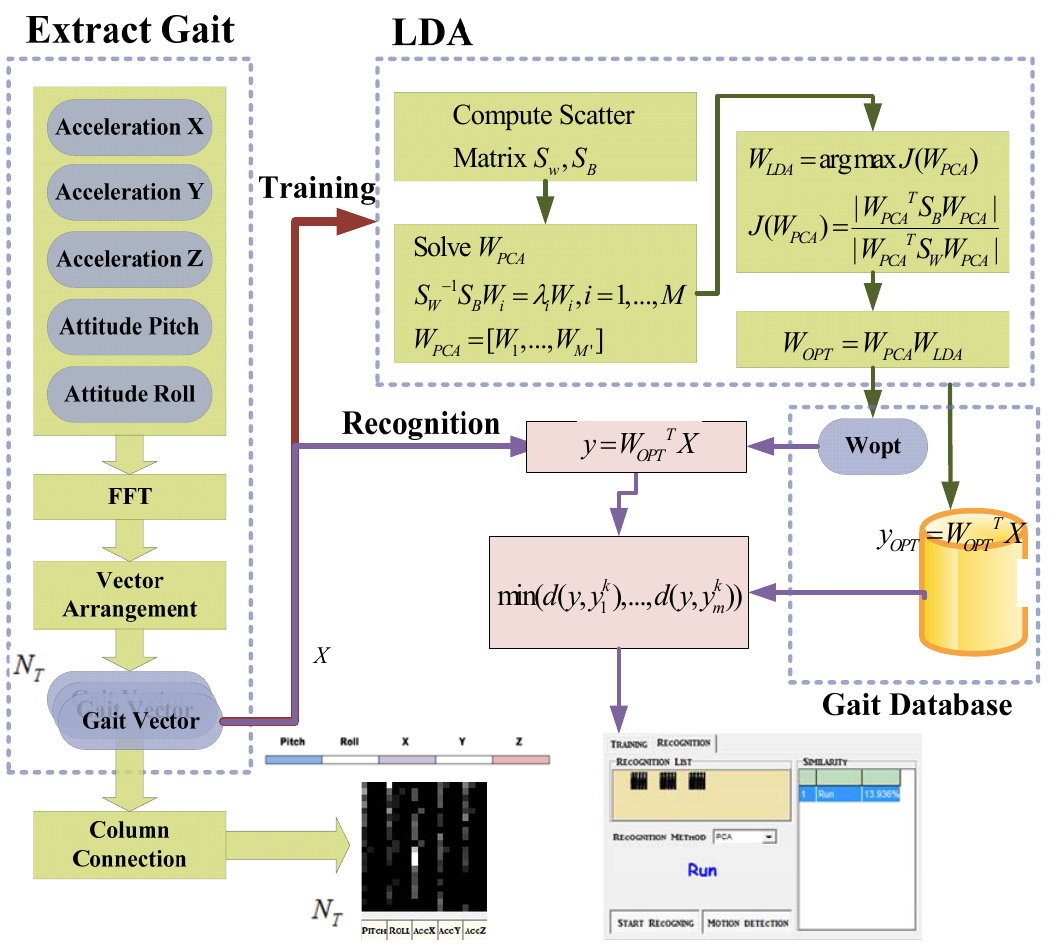
Figure 5. The flowchart of gait training and recognition